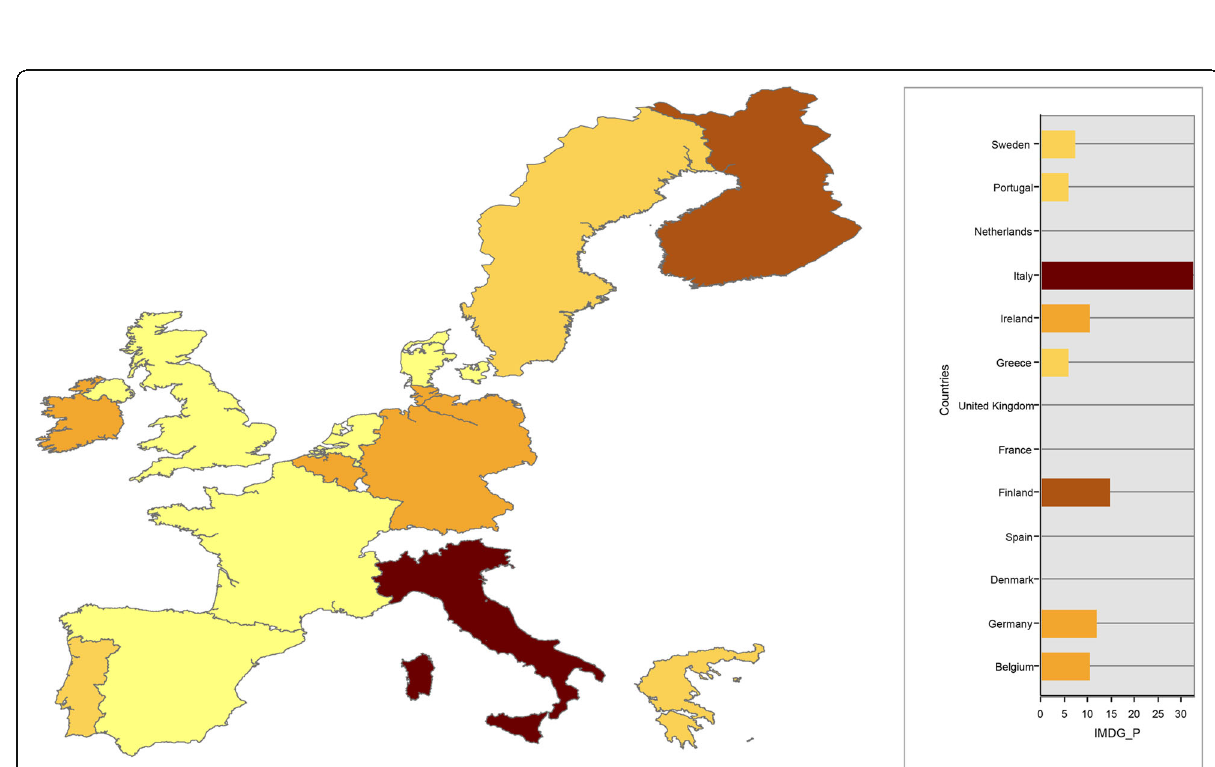
Fig. 8 Detainable remarks percentage for Dangerous Goods for EU15